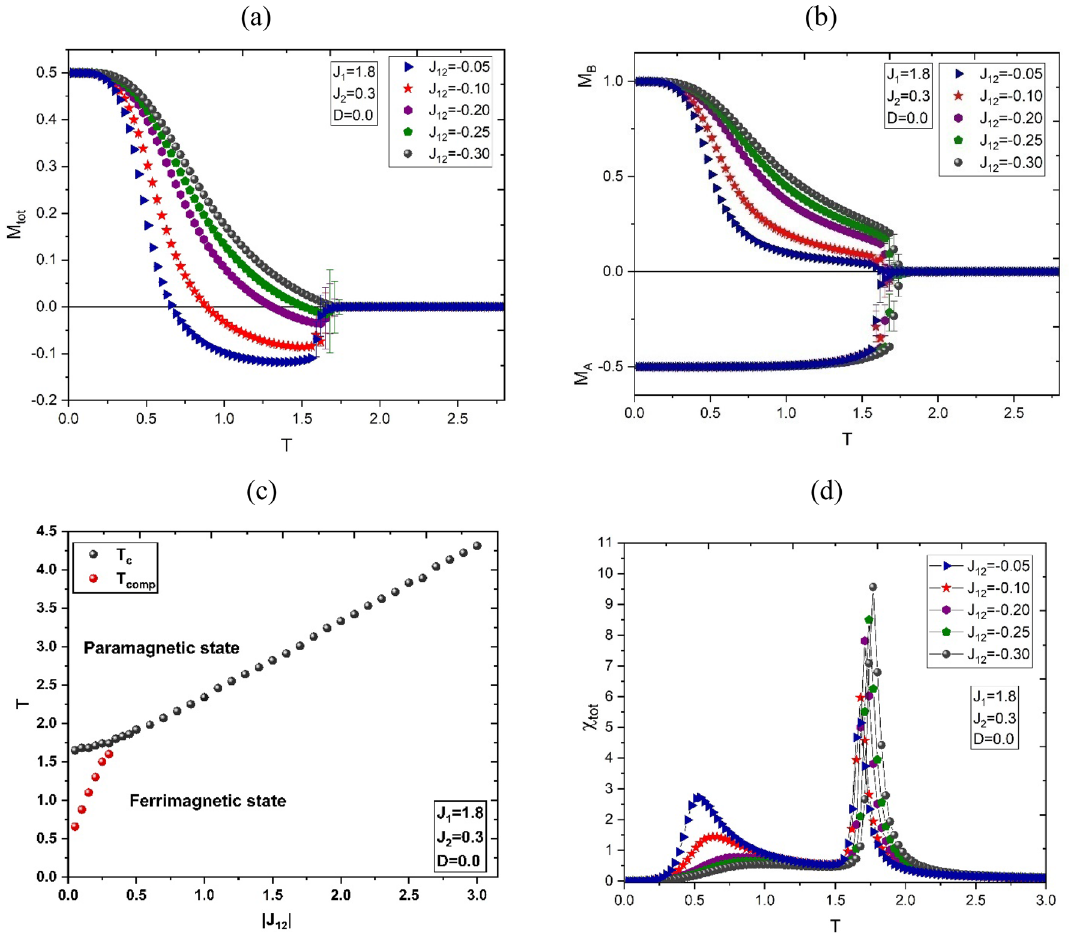
Fig. 4 Effect of J 12 coupling constant on a total magnetization, b sublattices magnetization, c critical and compensation temperature, and d total susceptibility of the system at fixed J 1 = 1.8, J 2 = 0.3, D =